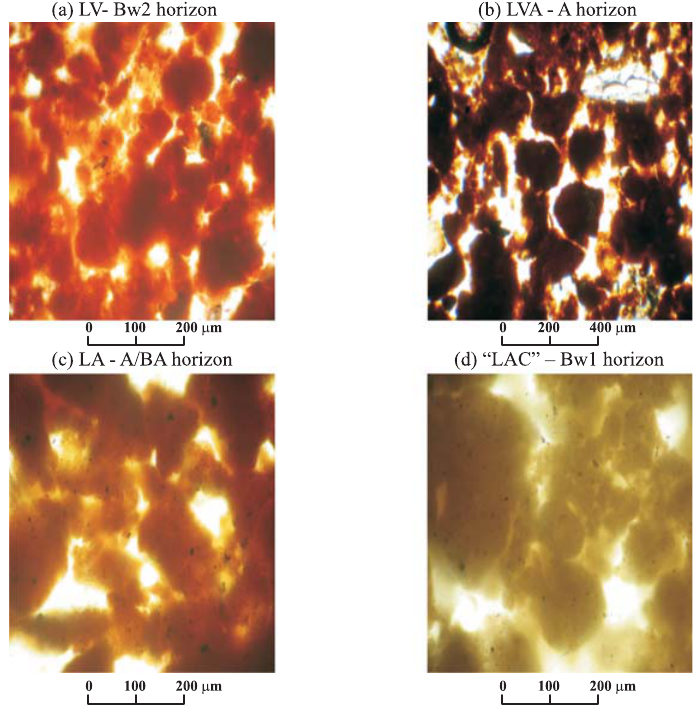
Figure 4. Photomicrographs of the pedons of the